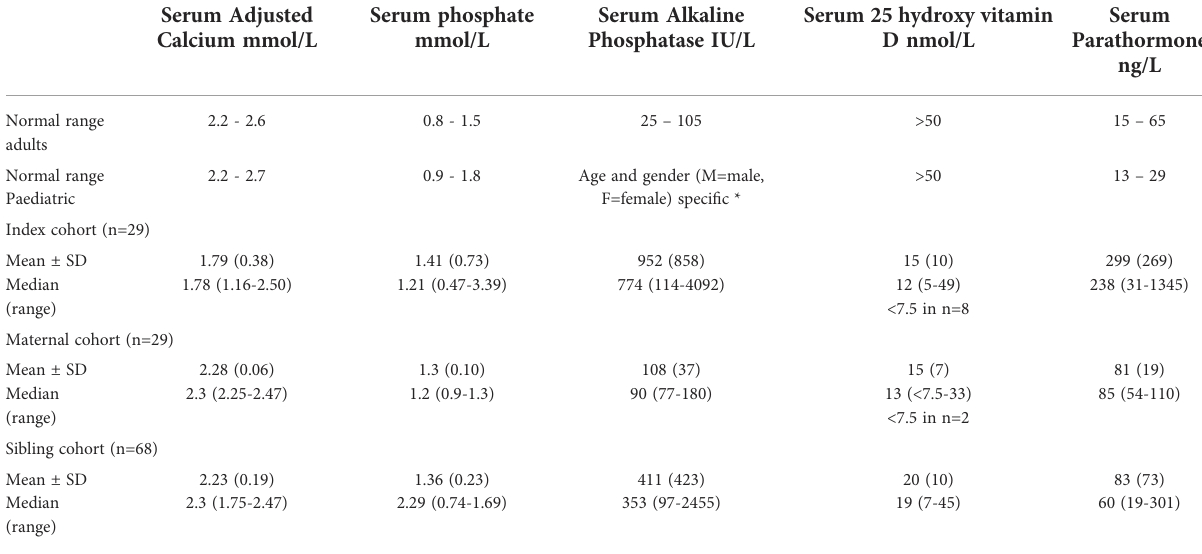
TABLE 1 Biochemical parameters in the index, maternal and sibling